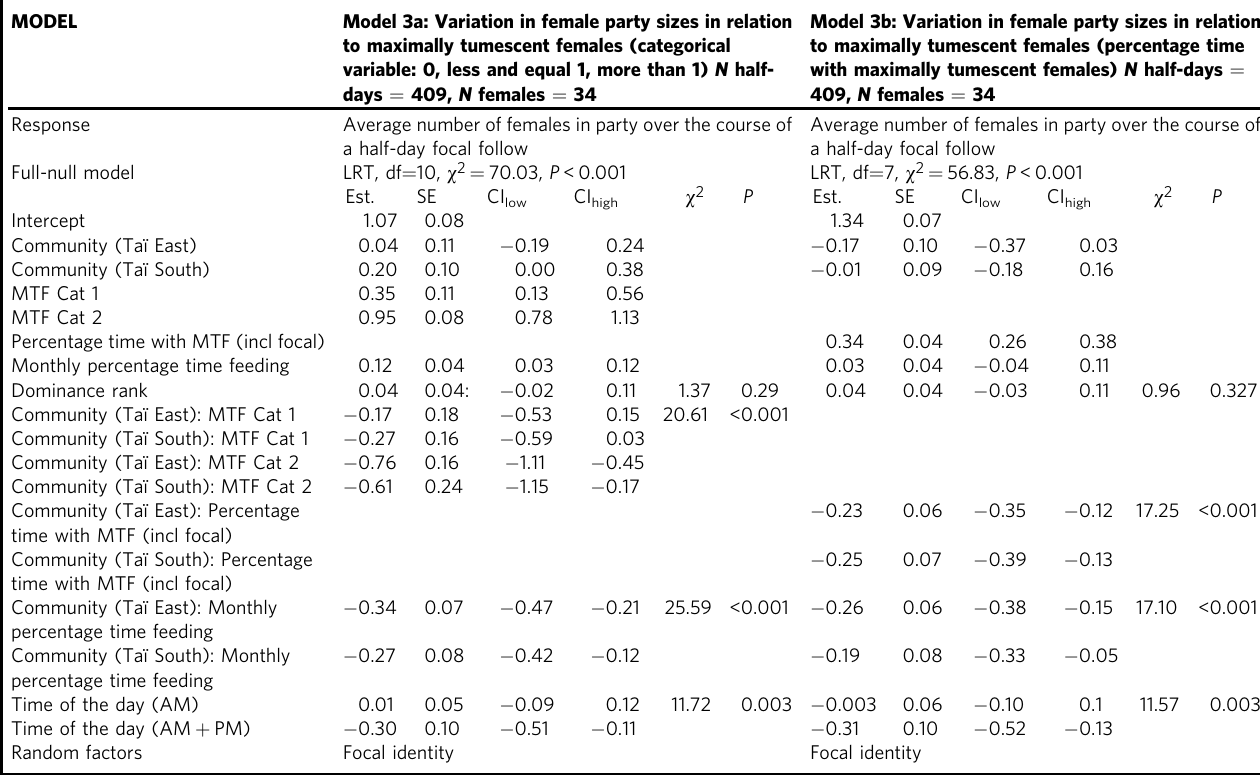
Table 3 Overview over structure and results of the models analyzing differences in female association patterns between one bonobo (Bompusa) and two chimpanzee communities (Taï East and Taï South) in relation to the presence of maximally tumescent females (MTF) while controlling for monthly percentage time feeding (proxy for fl uctuation in food availability) and with bonobos and no MTF present as the reference. Model 3b: Variation in female party sizes in relation Model 3a: Variation in female party sizes in relation to maximally tumescent females (percentage time to maximally tumescent females (categorical with maximally tumescent females) N half-days = variable: 0, less and equal 1, more than 1) N half- 409, N females = days = 409, N females = 34